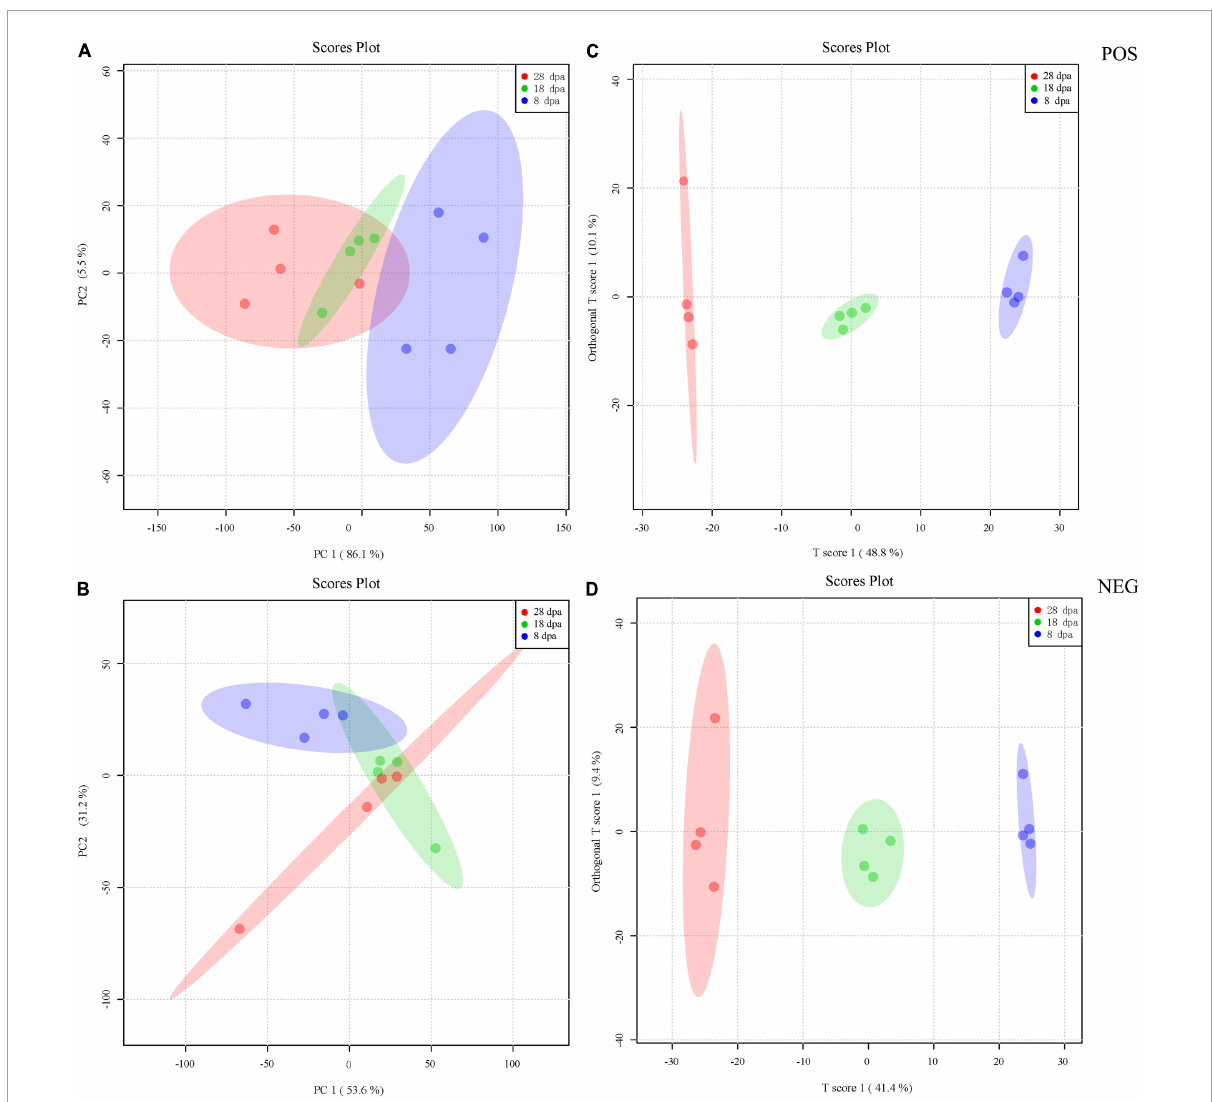
FIGURE4 PCA and OPLS-DA score plot derived from the LC-MS spectra of extracts obtained from seed development stages at 8 (blue), 18 (green), and 28 dpa (red). (A,B) PCA was first used to obtain an overview of metabolic profiles of the 8, 18, and 28 dpa conditions under the POS and NEG. The different plots represent combinations of the first and second principal components (PC1 and PC2). The proportions of explained variance are shown in brackets. (C,D) The OPLS-DA score plot was then employed to maximize the separation according to the classification of samples at different stages of seed development acquired under the POS and NEG. The proportions of explained variance are shown in brackets. Each development stage contains four